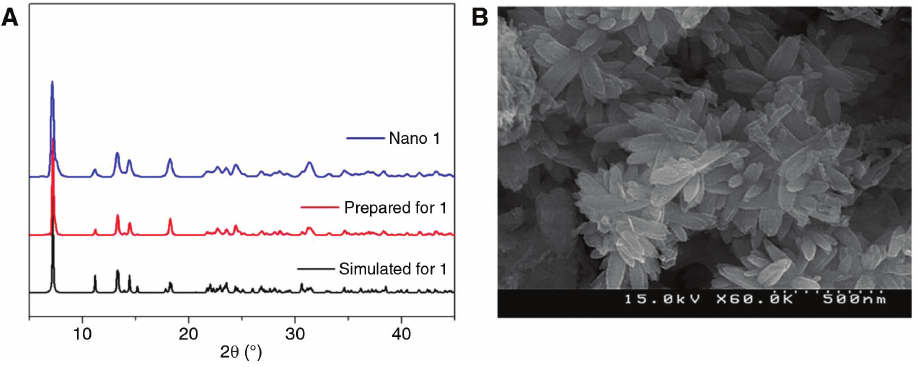
Figure 3: The PXRD pattern and SEM image for compound 1 . (A) The simulated and experimental X-ray powder diffraction curves for complex 1 ; (B) the SEM image of nano- 1 .